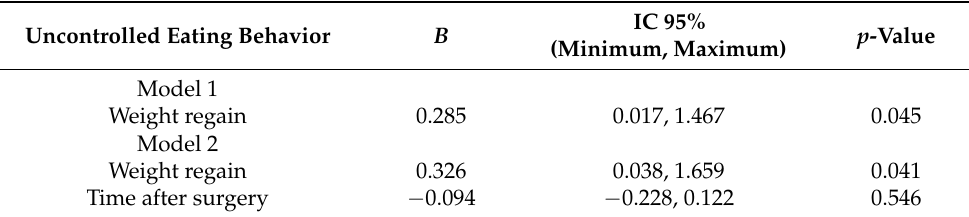
Table 4. Correlation between weight regain and uncontrolled eating behavior in women with more than 24 months after BS.